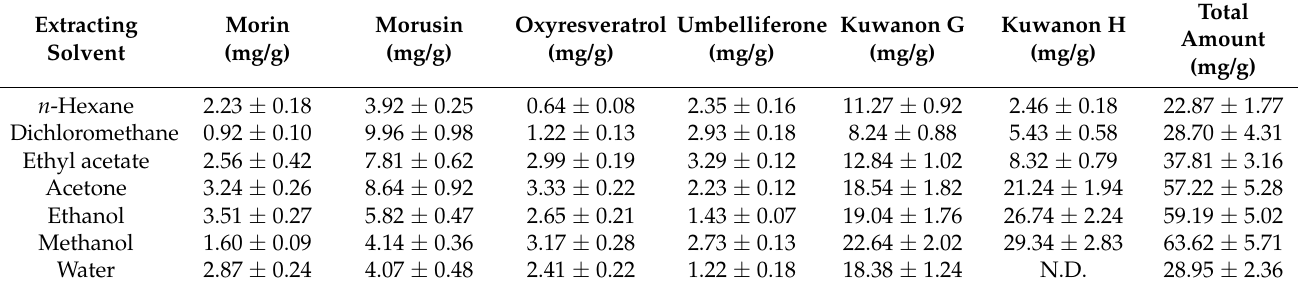
Table 5. Identification and quantification of the active components of Morus alba L. in solvent extracts.